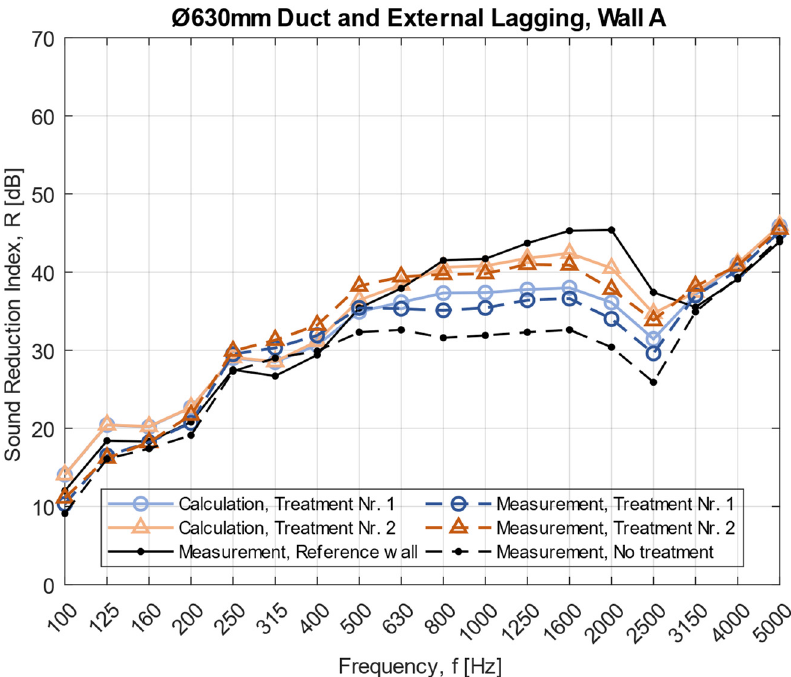
Figure A3. Theoretical models compared to measurements with external lagging as acoustic treatment. Ventilation duct with Ø315 mm through wall A with a sound reduction index of R w = 35 dB. External lagging is mounted at partial lengths of 0.6–1.2 m (Treatment 1 and 2) with 50 mm stone wool, density of 100 kg/m 3 , closest to the wall.